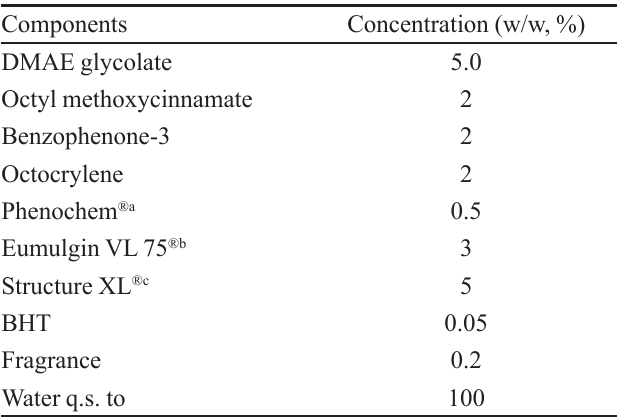
TABLE I - Components of the formulation studied